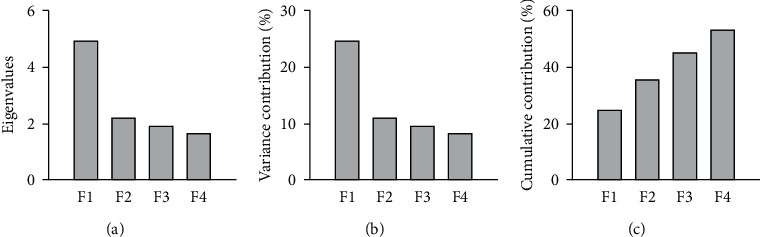
The variance contribution of the common factors. (a) The eigenvalue analysis of the 4 common factors. The common factors (F1-F4) were extracted based on the principles of eigenvalues greater than 1. (b) The variance contribution analysis of the common factors. (c) The cumulative contribution analysis of the common factors.